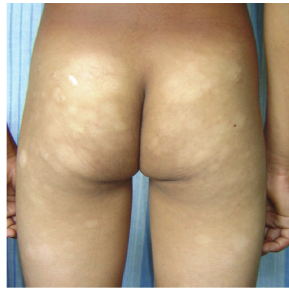
Figure 3: An 11-year-old boy had localized depigmented patches on buttocks and posterior upper thigh simulating vitiligo. He was misdiagnosed clinically and histopathologically as eczema and vitiligo for 3 years. This photograph was taken 8 months after potent topical steroid therapy (patient 3).